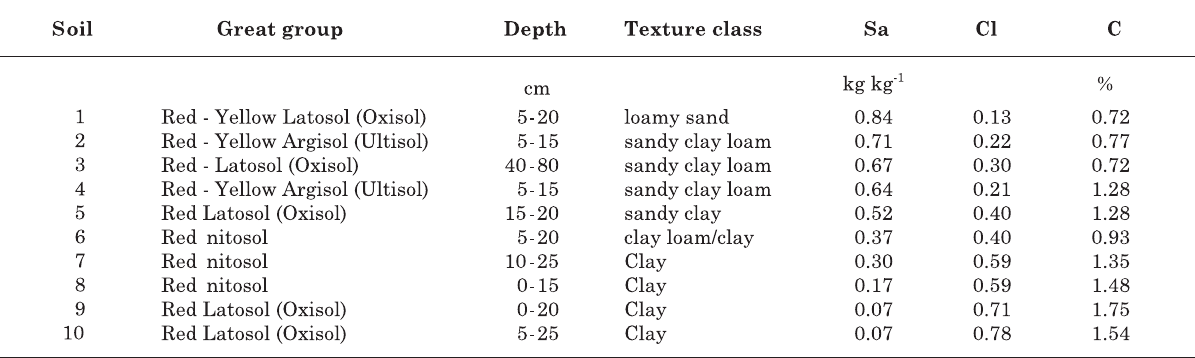
Table 1. Soil characterization: great group, sampling depth, texture class, sand (Sa), clay (Cl), and